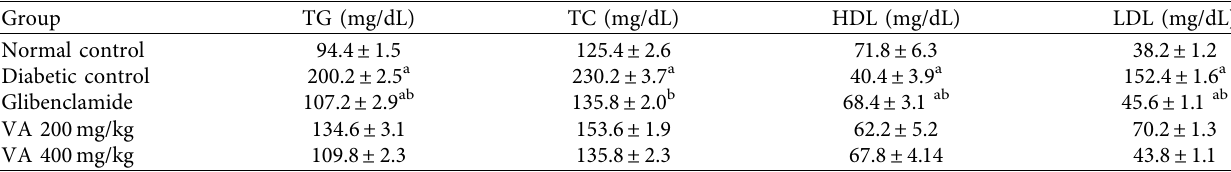
Table 2: Effect of V . album extract on lipid level in alloxan-induced diabetic animals.